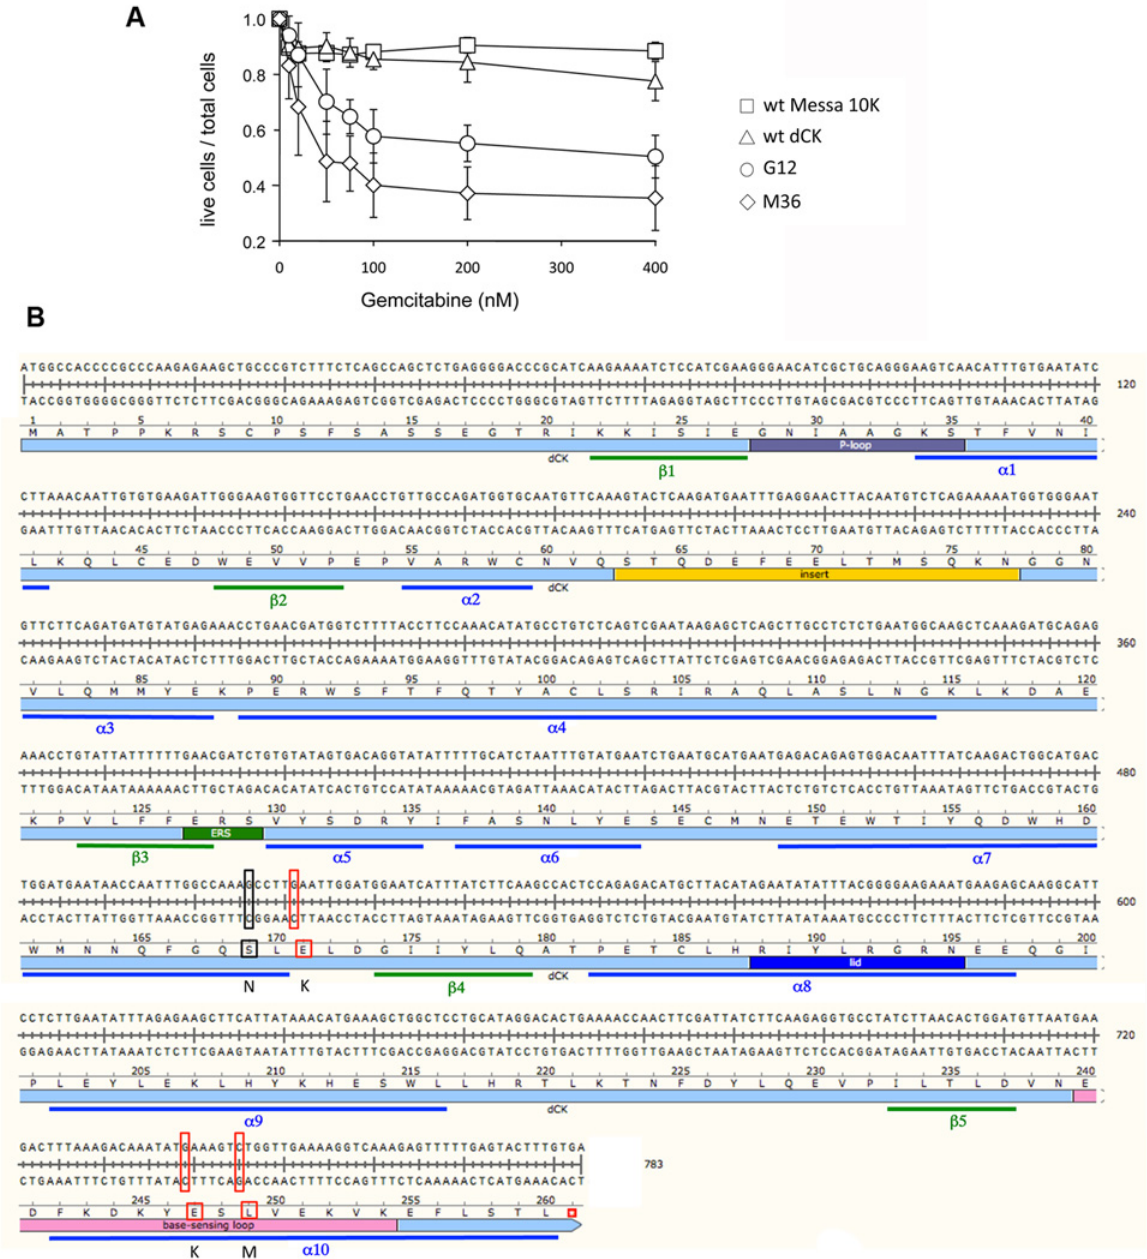
Fig 4. The M36 mutant. Panel A. Sensitivity to gemcitabine of Messa10K cells induced by M36. The ratio of living cells over the total number of cells is plotted as a function of the concentration of gemcitabine. Data are the average of five independent experiments. Panel B. Localisation of the mutations in the human dCK that characterise M36. The nucleotide sequence (double stranded) is given above, with the aminoacid sequence below. The full-length protein is given by a pale blue bar with the major functional domains, as defined in [28], indicated in